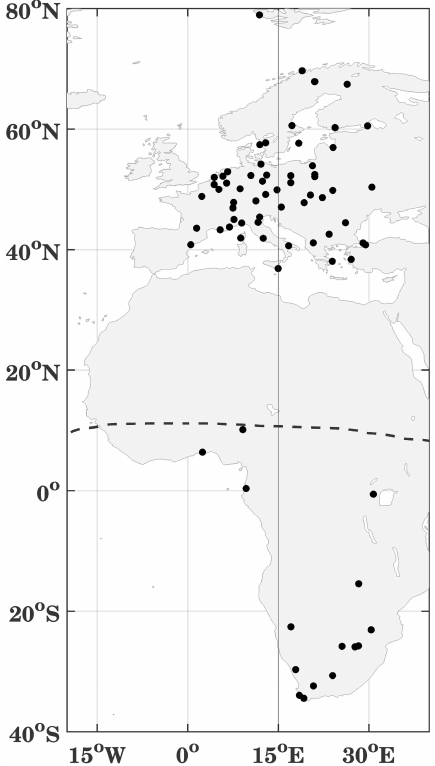
Figure 1. IGS stations around 15 ◦ E. The dashed black line repre- sents the geomagnetic